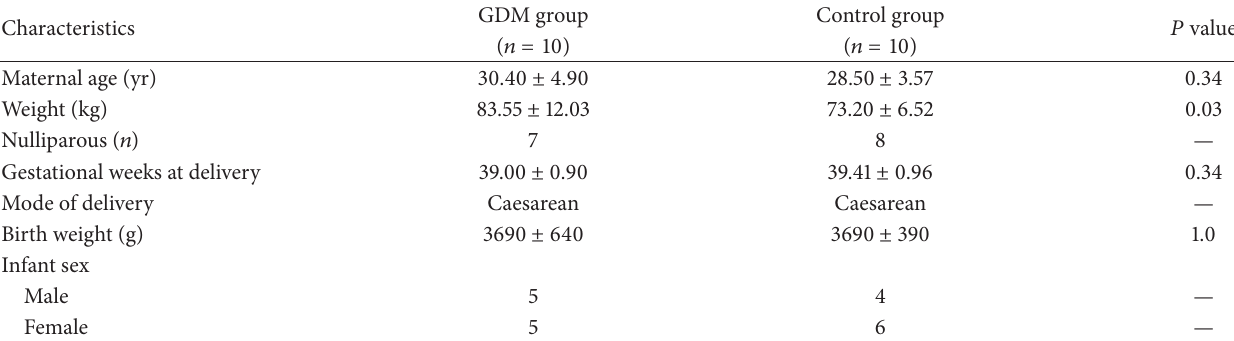
Table 1: Clinical characteristics of women with GDM ( 𝑛 = 10 ) and control group ( 𝑛 = 10